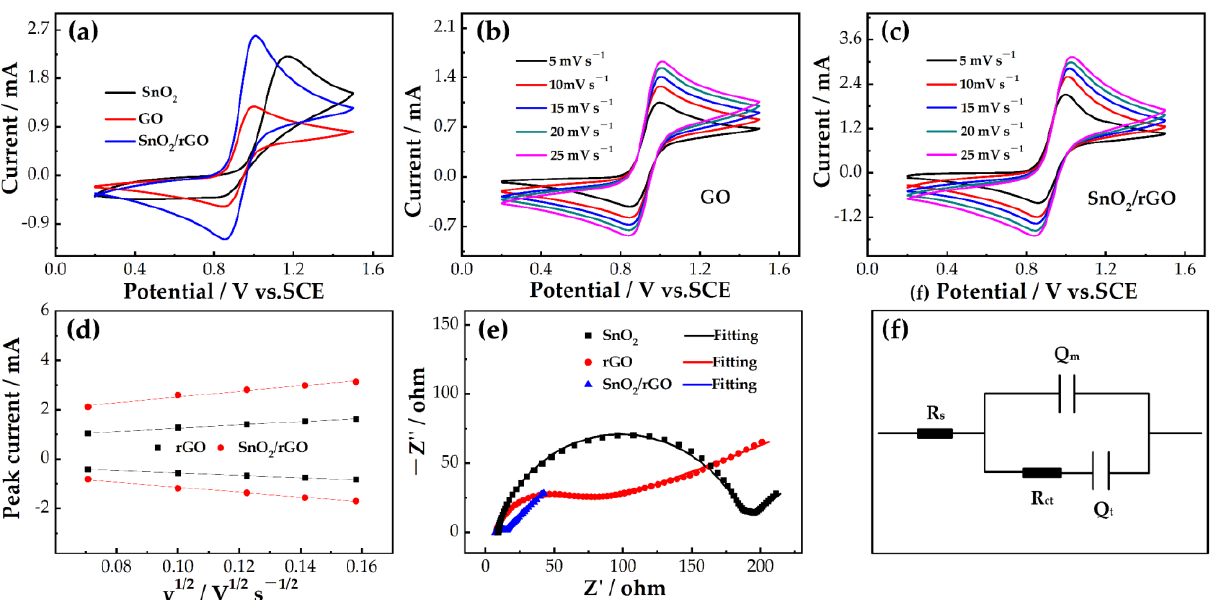
Figure 5. ( a ) CV curves for SnO 2 , GO, and SnO 2 /rGO in 1.6 M VO 2+ + 3.0 M H 2 SO 4 at a scan rate of 10 mV s − 1 ; ( b ) CVs for GO; ( c ) CVs for SnO 2 /rGO; ( d ) CVs at different scan rates (5 – 25 mV s − 1 ) in 1.6 M VO 2+ + 3.0 M H 2 SO 4 , and plots of the redox peak current versus the square root of the scan rate for GO and SnO 2 /rGO electrodes; ( e ) Nyquist plots for SnO 2 , GO, and SnO 2 /rGO in 1.6 M VO 2+ + 3.0 M H 2 SO 4 at 0.85 V; ( f ) simplified electrical equivalent circuit fitting with Nyquist plots.